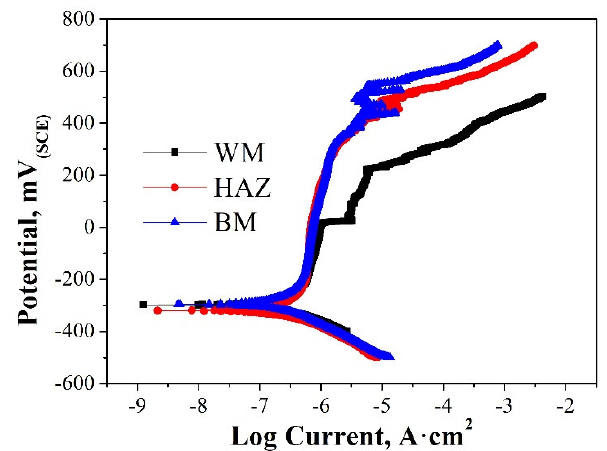
Figure 9. Potentiodynamic polarization curves of different sections in the 308L-316L welded joint. Table 1. Corrosion and pitting potentials of the 308L-316L welded joint in the 3.5 wt.% NaCl solution. Section